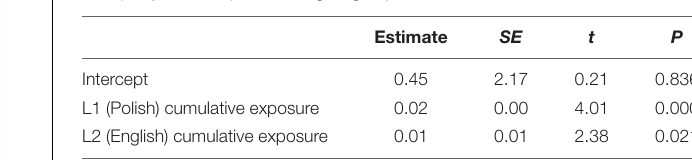
TABLE 7 | The best regression model predicting performance in the discourse task (story structure) in the bilingual group.